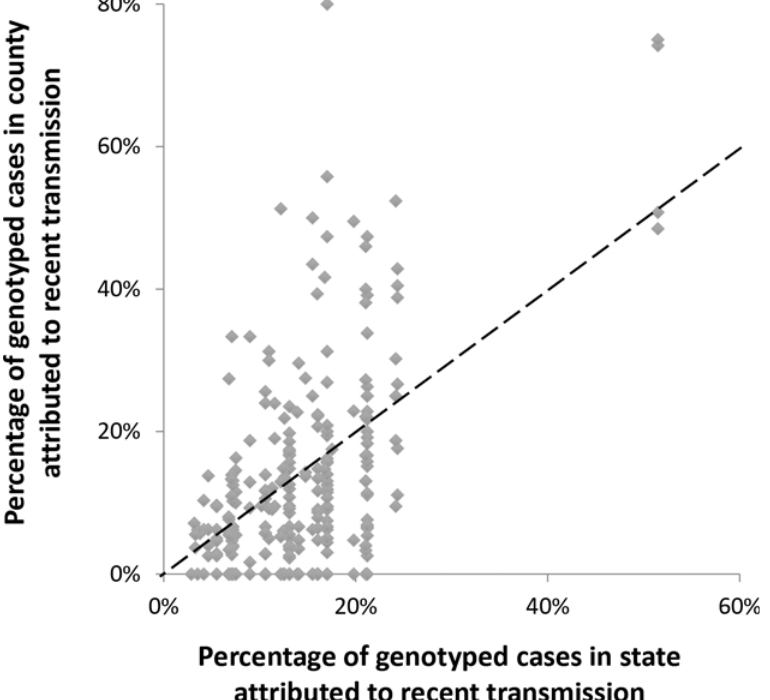
Fig 1. Proportion of genotyped cases attributed to recent transmission in each county compared to proportion of genotyped cases attributed to recent transmission in state where county is located — January 2011 – September 2014. Each point represents one county. Only counties with (cid:1) 15 genotyped cases during the analysis period (i.e., an average of one case per quarter) are shown. Points would be expected to cluster around the dashed black line if every county within a given state had the same proportion of cases attributable to recent transmission as the entire state.